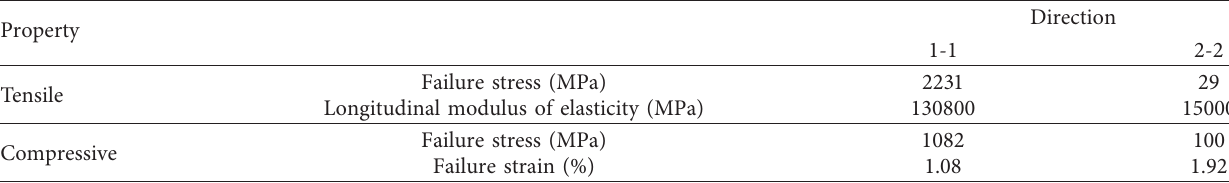
Table 2: Properties of the laminate.